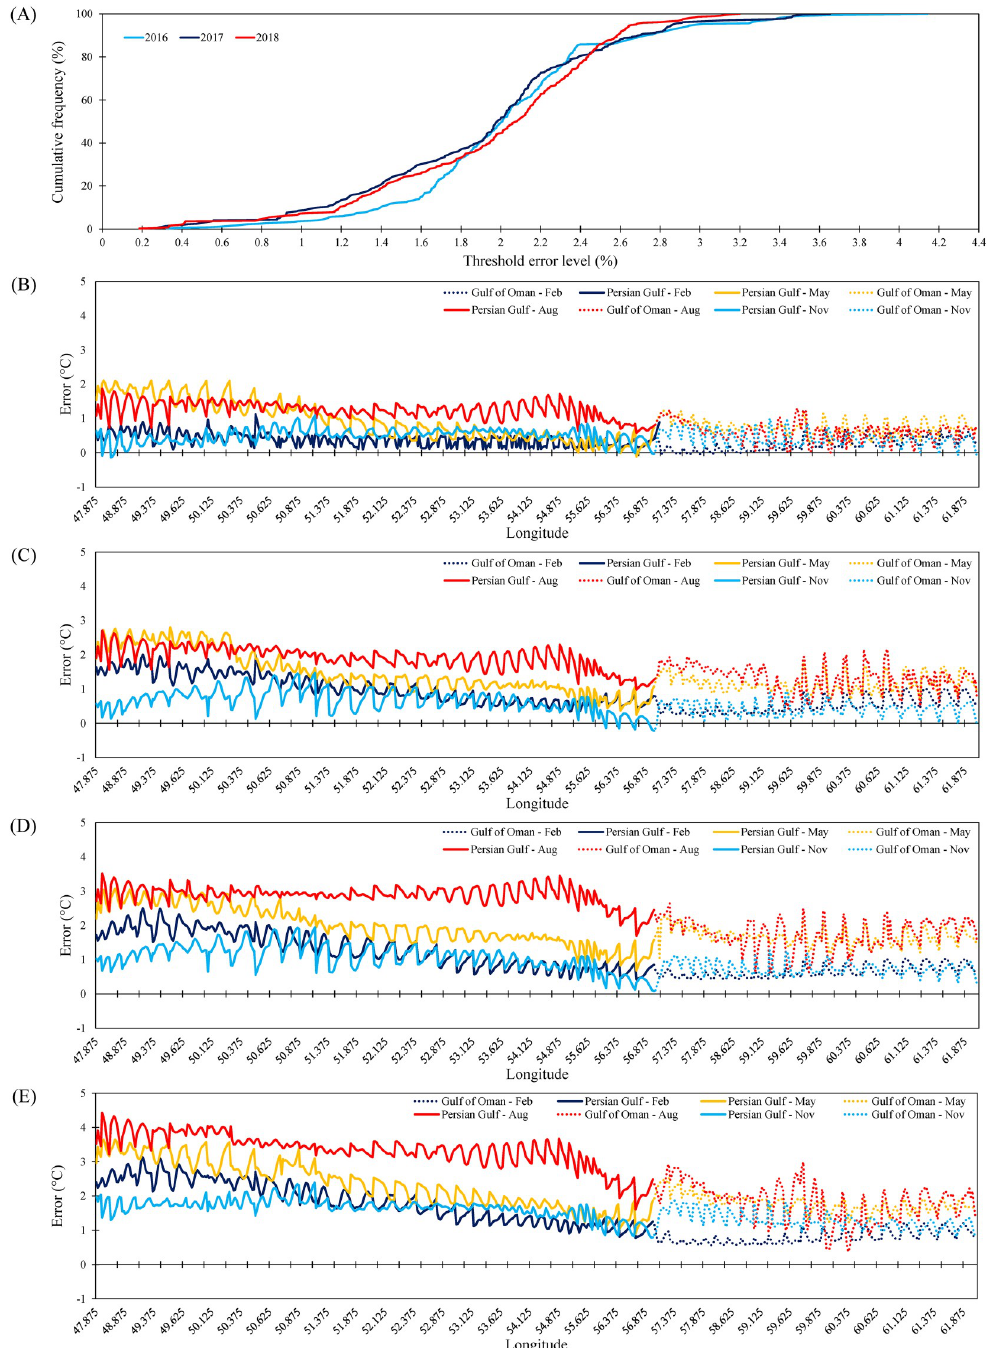
Fig 8. ( A ) Mean absolute relative error between sea surface temperature (SST) values for the Persian Gulf & Gulf of Oman (PG&GO) predicted by the proper orthogonal decomposition (POD) model and measured during the period 2016–2018; and spatial trends in mean monthly SST in ( B ) February (representing winter), ( C ) May (representing spring), ( D ) August (representing summer), and ( E ) November (representing fall) in the selected future years 2030, 2050, 2070, and 2100.